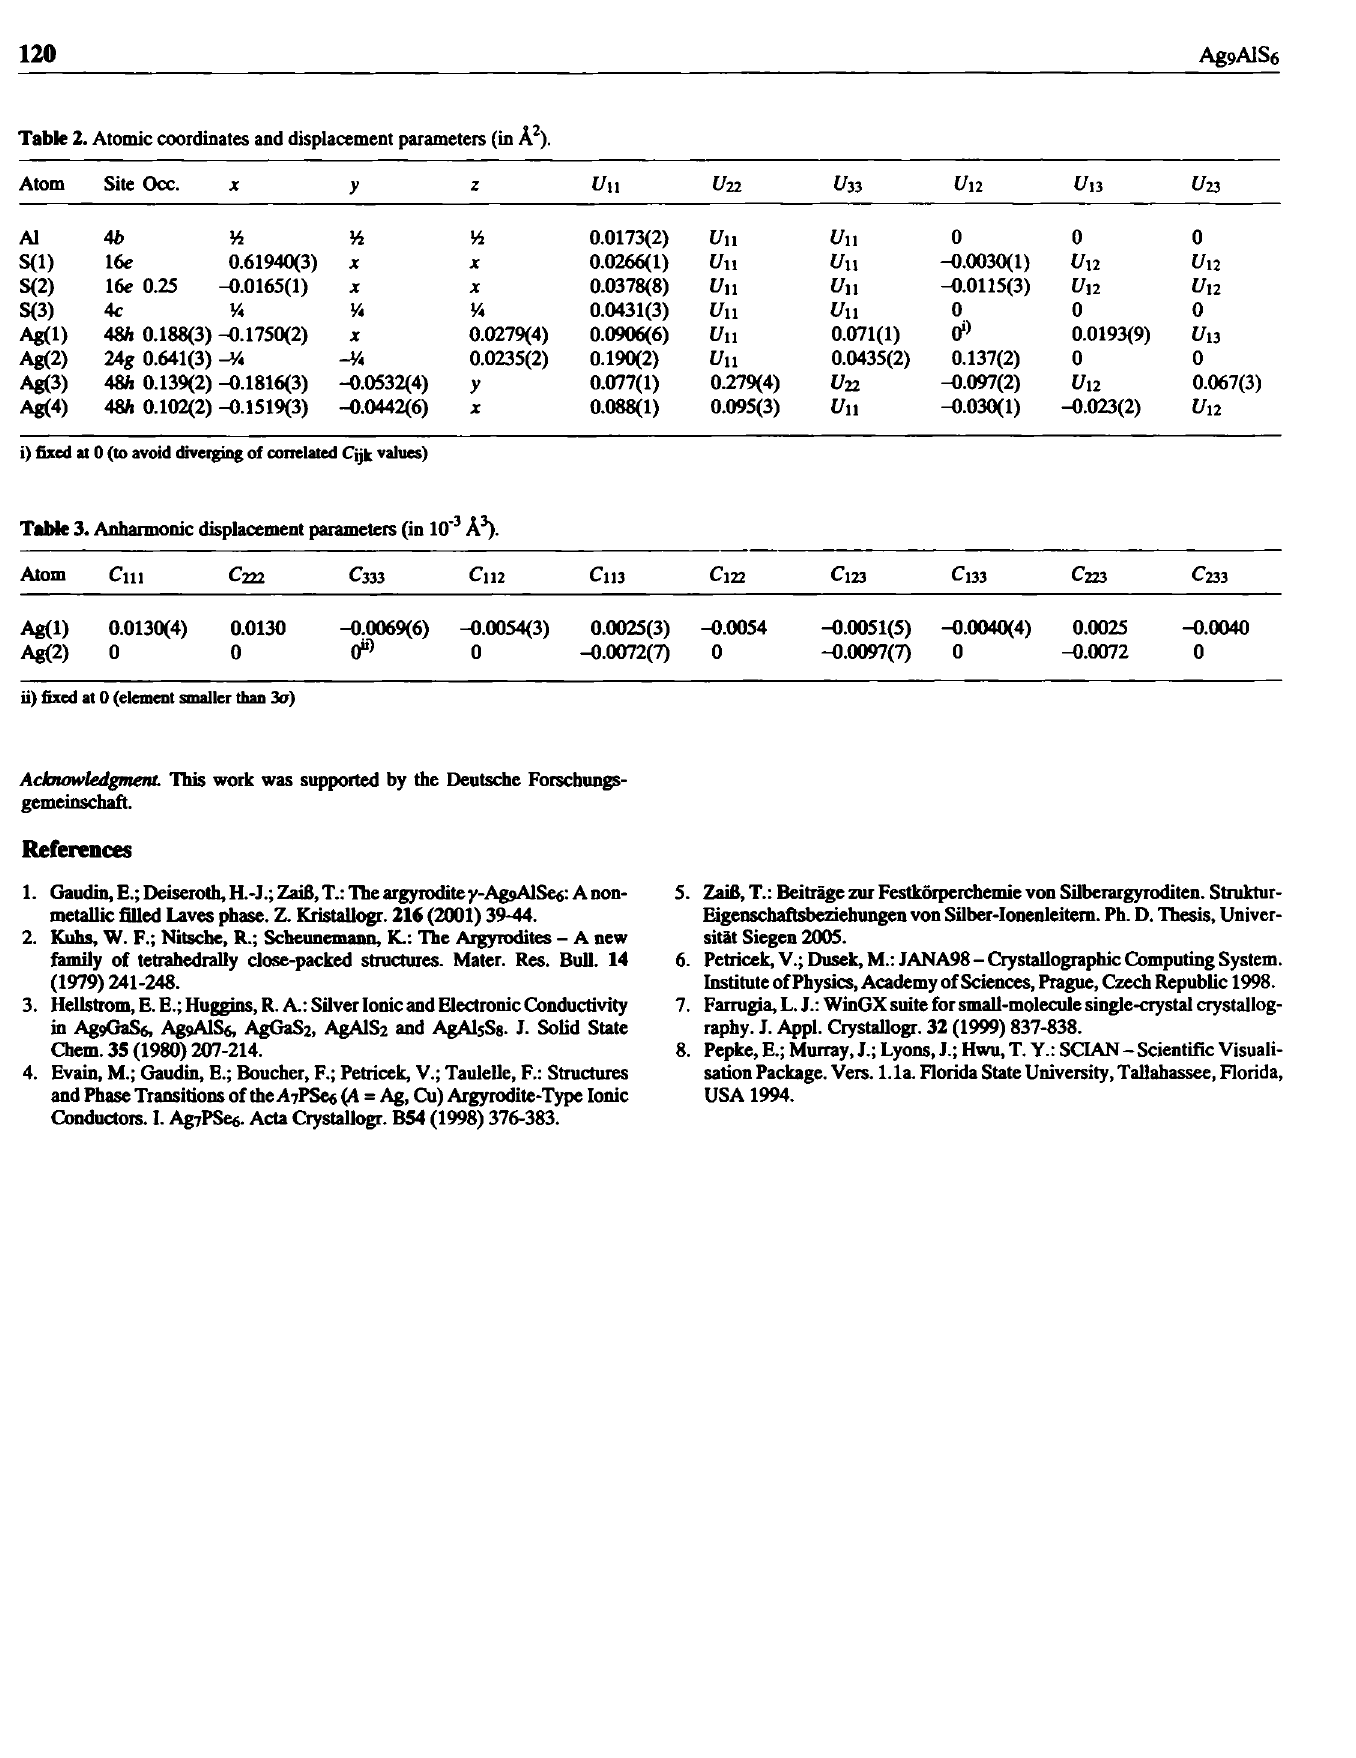
Table 2. Atomic coordinates and displacement parameters (in Ä 2 ).